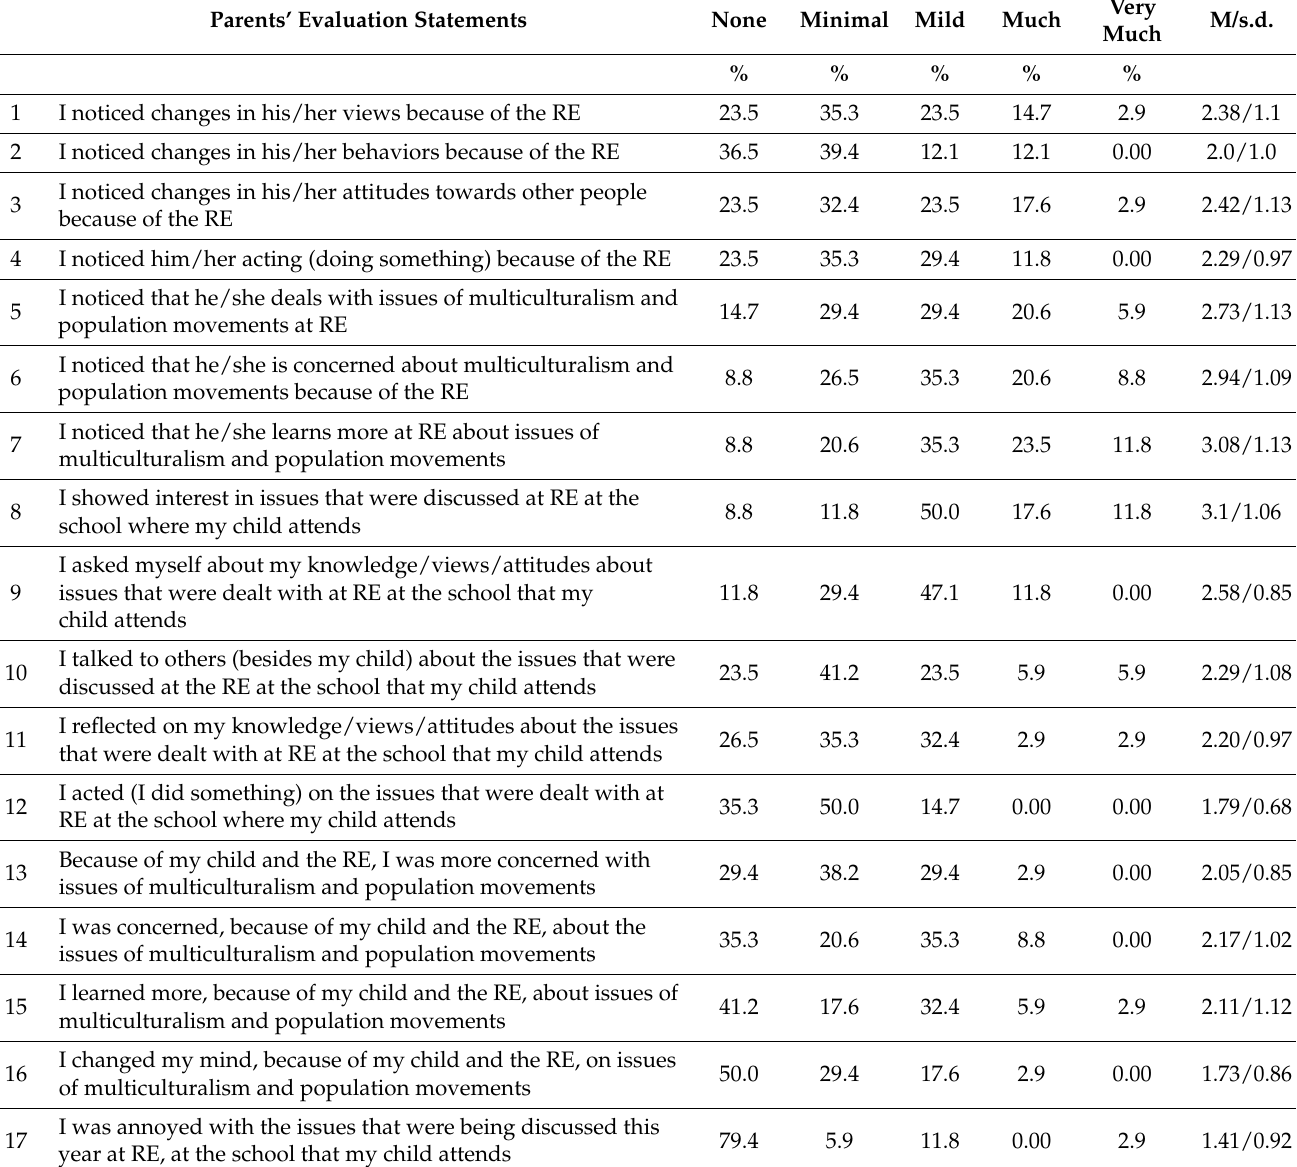
Table 12. Evaluation of the interventional function of the knowledge of RE in the students’